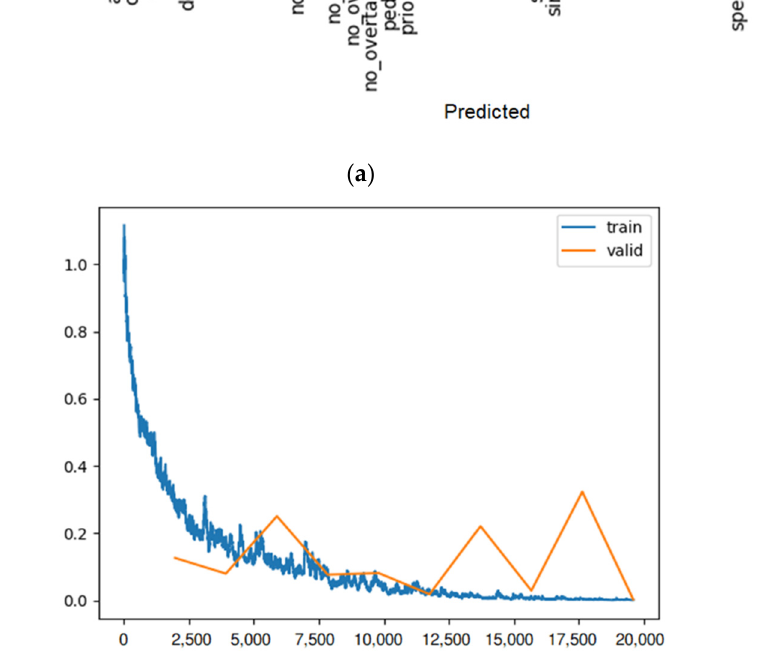
Figure 14. ( a ) Confusion matrix and ( b ) loss rate during training with SqueezeNet1_1.